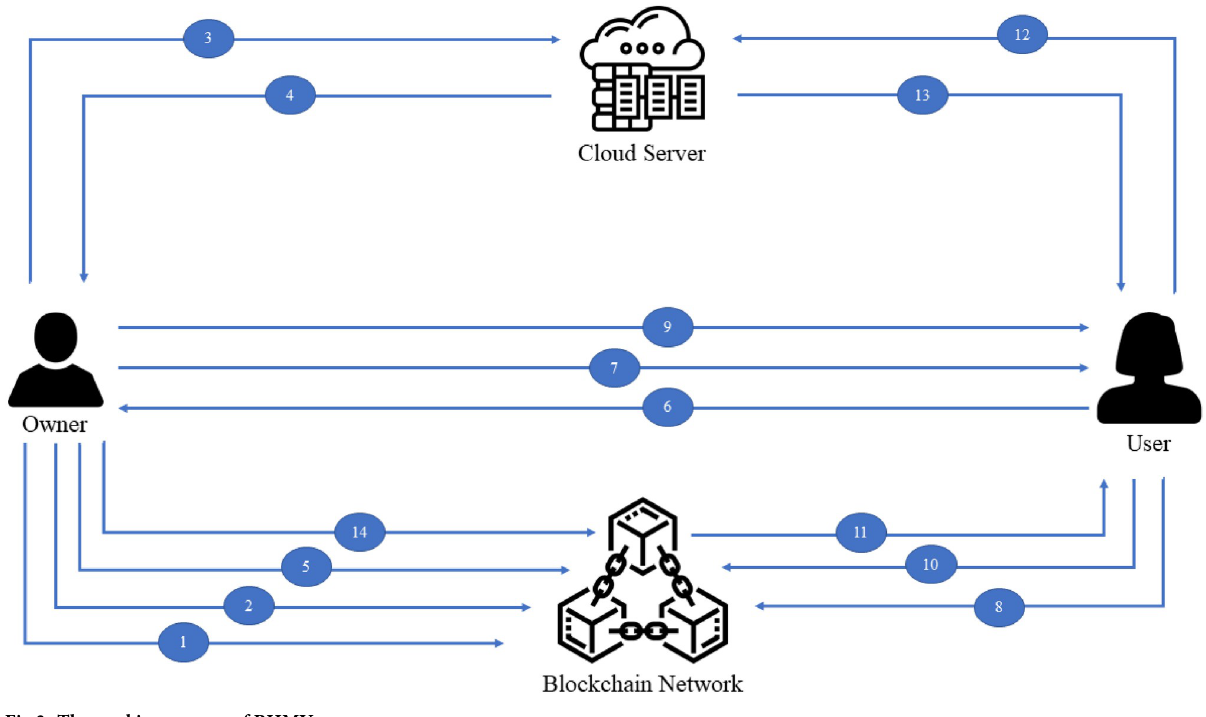
Fig 3. The working process of